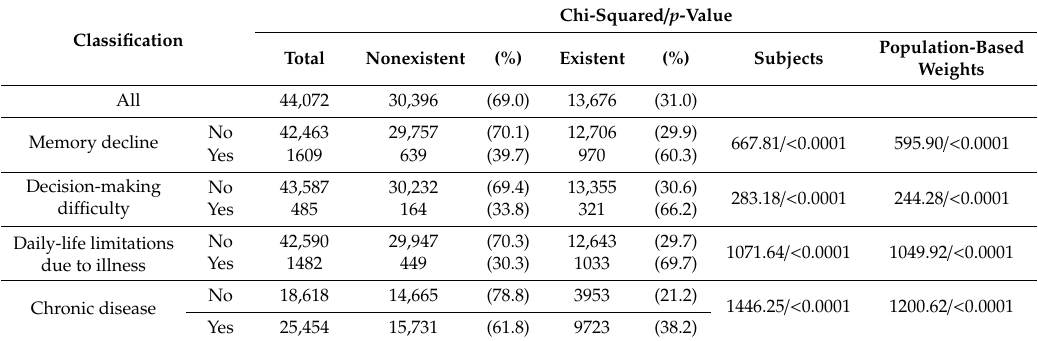
Table 4. Prevalence of food-chewing discomfort by cognitive and physical health.